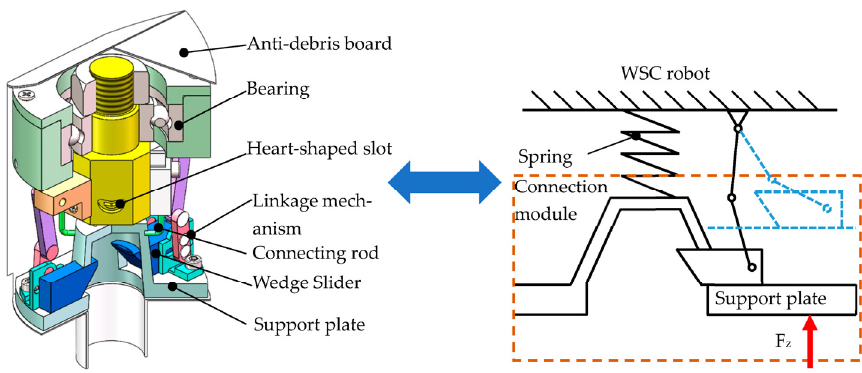
Figure 7. Design and operating mechanism of the connection module.